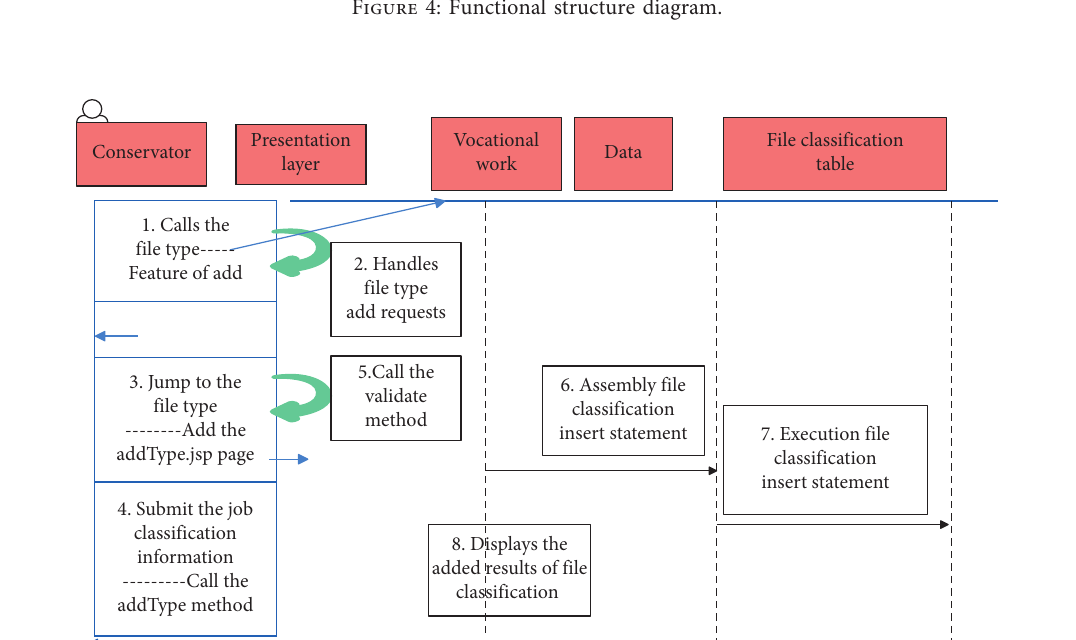
Figure 5: Timing diagram of category